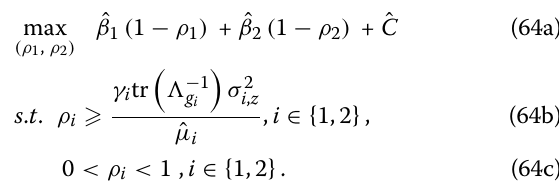
Algorithm 2 has lower computational complexity